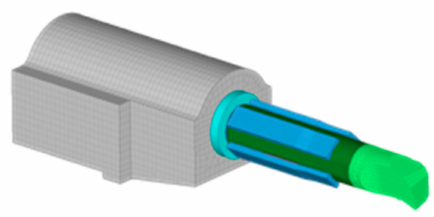
Figure 16. Active boring bar FE model for protective covers design.